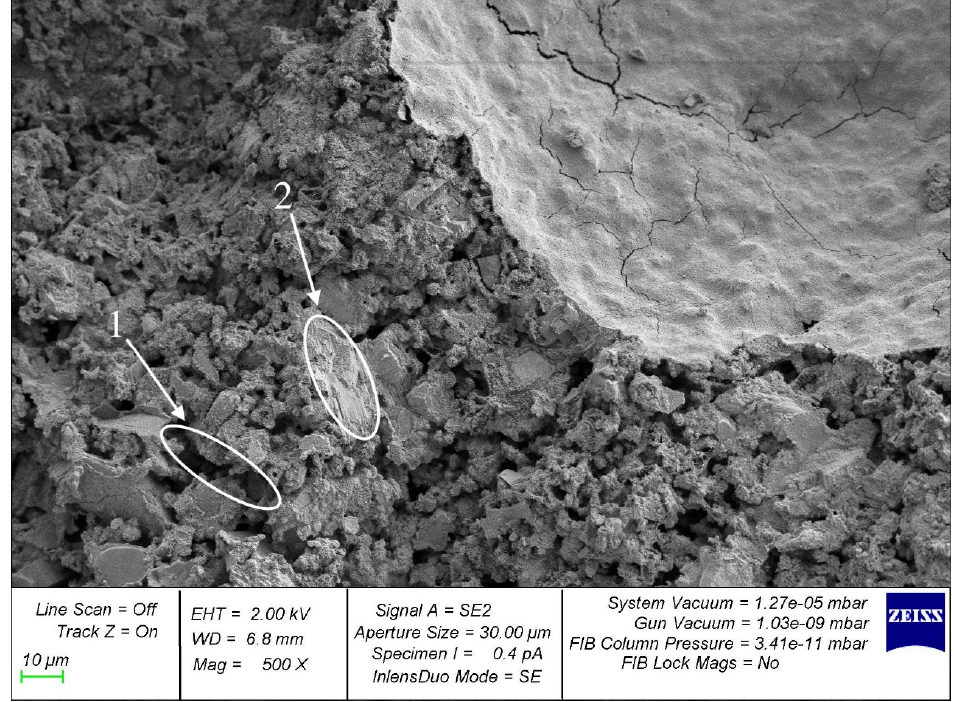
Figure 16. Sample with 10% snail shell powder dosage (1—porosity, 2—binder phase).